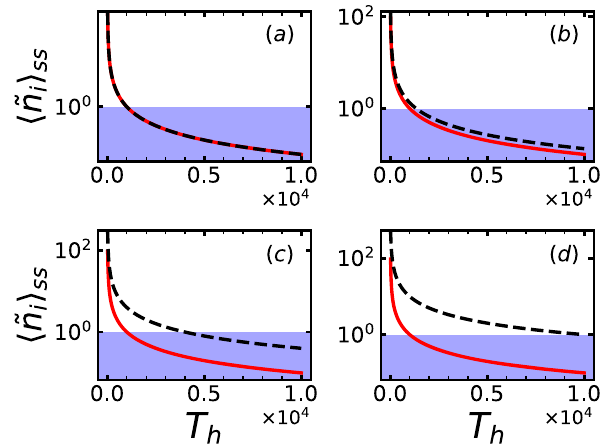
Fig. 5 Multiple mechanical resonators cooling. The steady-state mean as a function of the hot bath temperature T h . Solid, and phonon number h ~ n i i ss dashed lines are for the fi rst and second mechanical resonator,